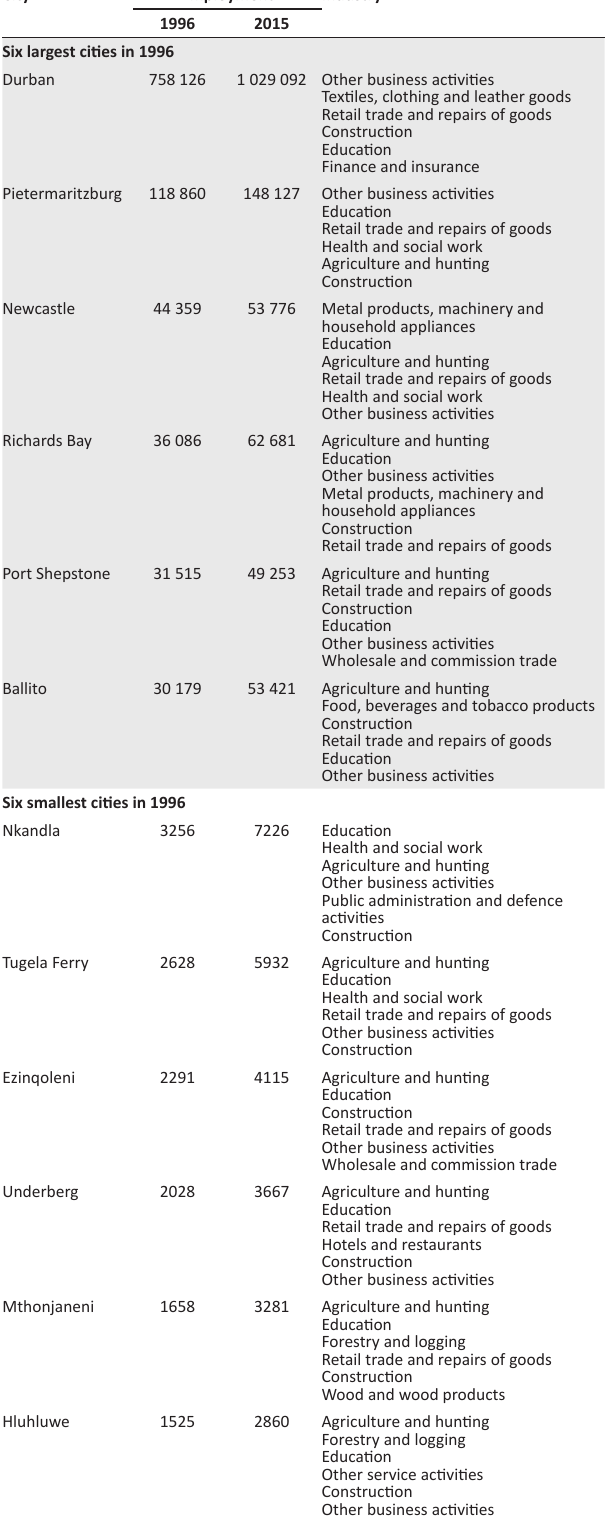
TABLE 2: Description of the data: Panel B (included city-industries in the 12 cities). Industry